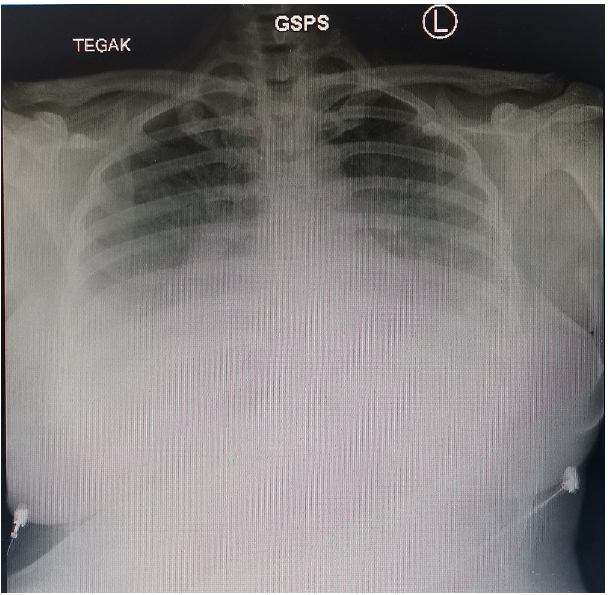
Figure 1. The patient's chest x-ray in the upright position.